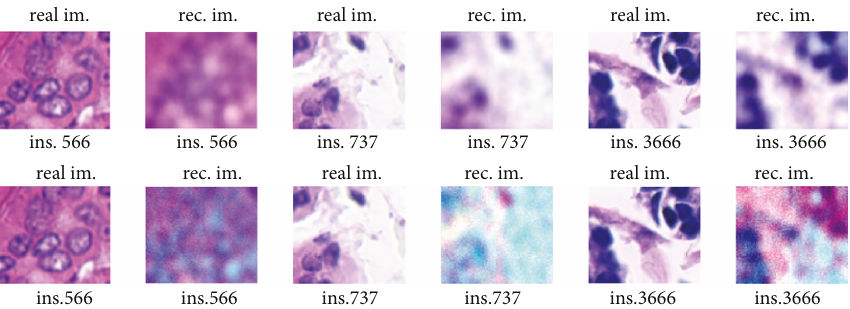
Figure 4: Random patches from BC images and their reconstruction with full values (upper row) using ALS and from 10% observed values using StrProxSGD (lower